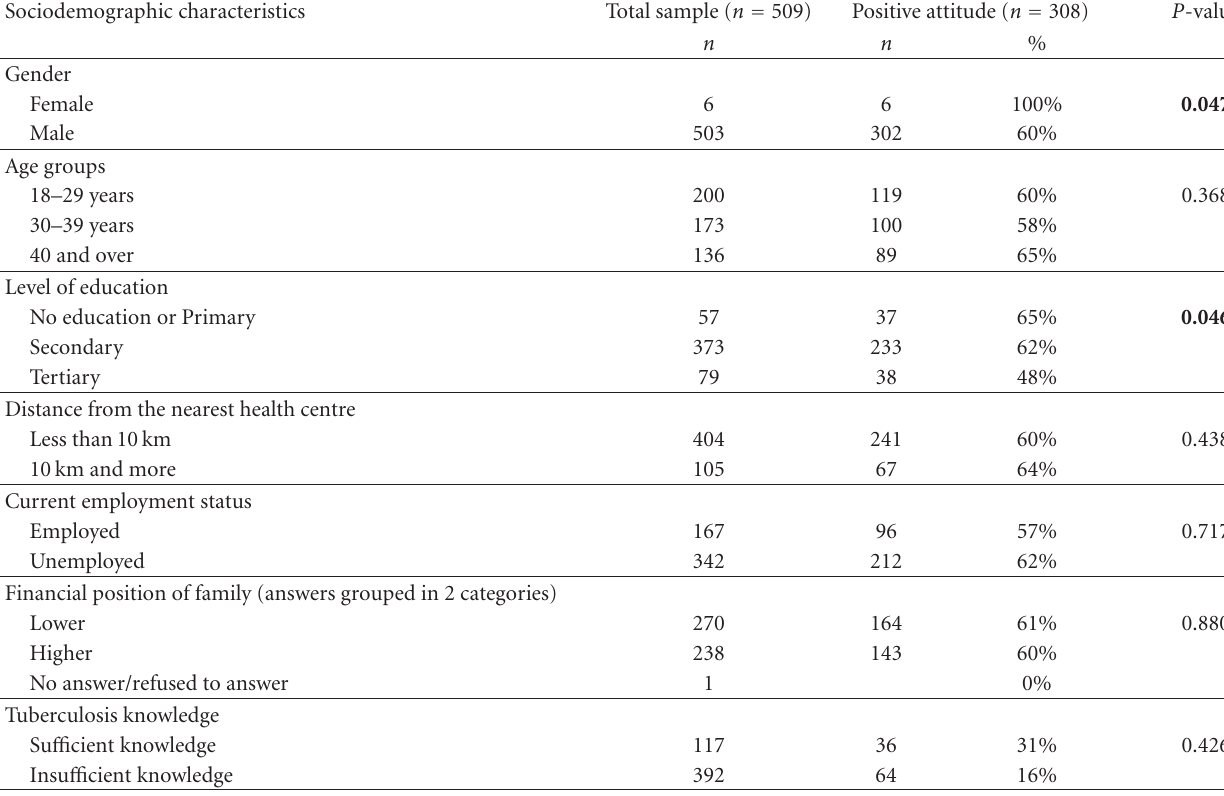
Table 3: Attitude and stigma towards TB associated with main sociodemographic characteristics of migrants. Sociodemographic